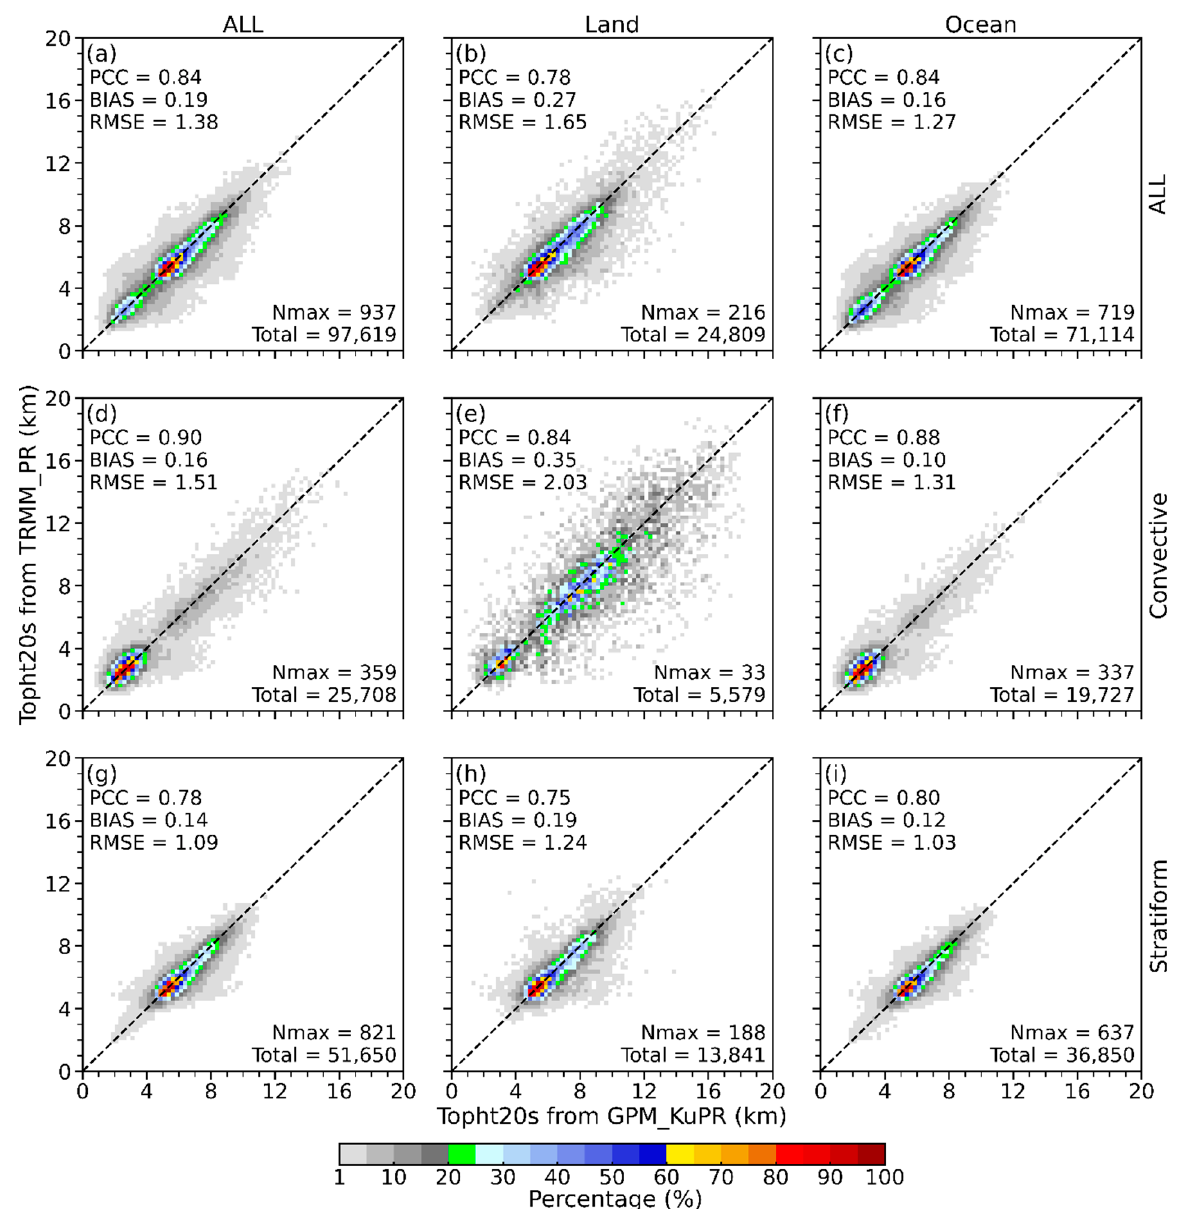
Figure 5. Two-dimensional density distributions of coincident Topht20 from the TRMM_PR (y-axis) and GPM_KuPR (x-axis) with a statistical grid resolution of 0.25 km × 0.25 km. Sub-groups are classified by rain types in rows (( a – c ) ALL, ( d – f ) Convective, and ( g – i ) Stratiform) in rows and land surface types (( a , d , g ) ALL, ( b , e , h ) Land, and ( c , f , i ) Ocean) in columns. The Pearson correlation coefficient (PCC), bias (GPM_KuPR − TRMM_PR, BIAS), and the root-mean-square error (RMSE) are provided. The maximum and total sample number in each grid are noted by Nmax and Total, respectively. Grid densities (shaded) are normalized by dividing the grid sample numbers by the Nmax in each